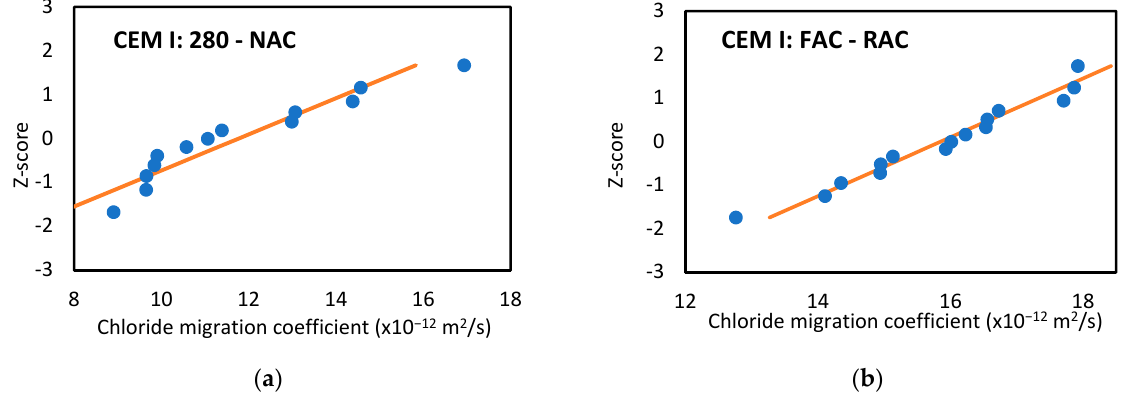
Figure 5. Normal probability plots of chloride migration coefficient of: ( a ) CEM I: 280 - NAC; ( b ) CEM I: FAC - RAC.